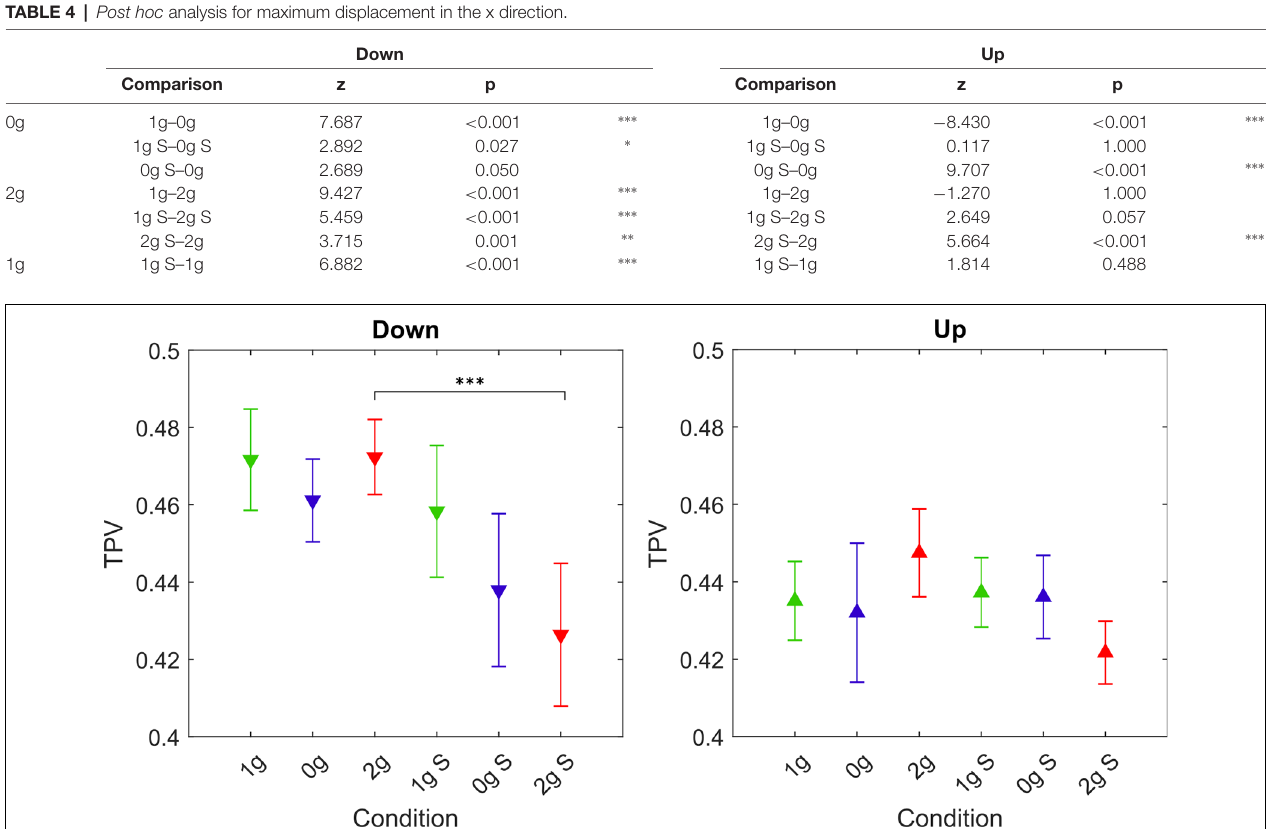
FIGURE 8 | Values of the TPV parameter for different gravitational and simulation conditions. Downward-pointing triangles denote mean values for downward movements, upward-pointing triangles denote mean values for upward movements, the whiskers denote the standard error of the mean. Green represents normogravity, blue represents microgravity and red represents hypergravity conditions, (1g, 0g, 2g) denote in-flight gravitational conditions, (1g S, 0g S, 2g S) denote simulated gravitational conditions. ∗∗∗ p < 0.001.